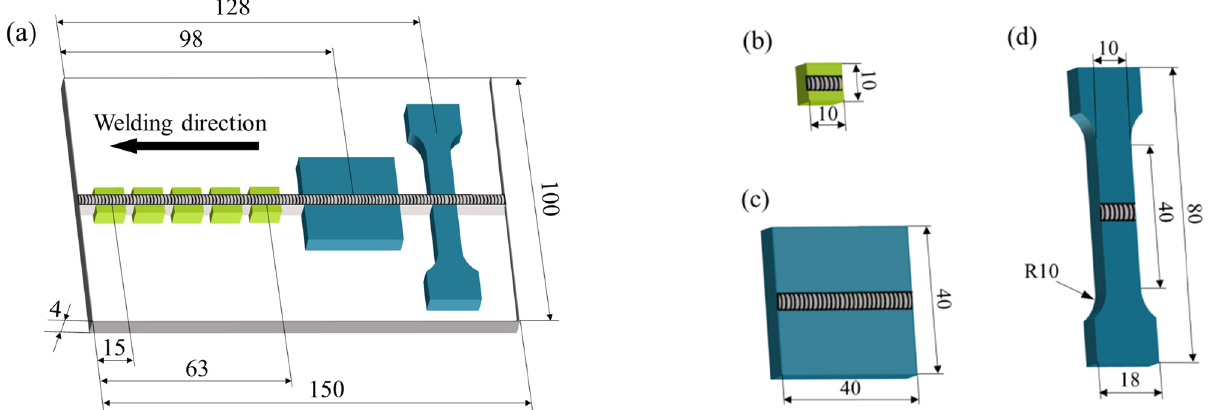
Figure 2: Schematic diagram of extracting position and dimensions for analysis samples: ( a ) extracting position of sample, ( b ) micro - structure analysis sample, ( c ) corrosion sample, and ( d ) tensile